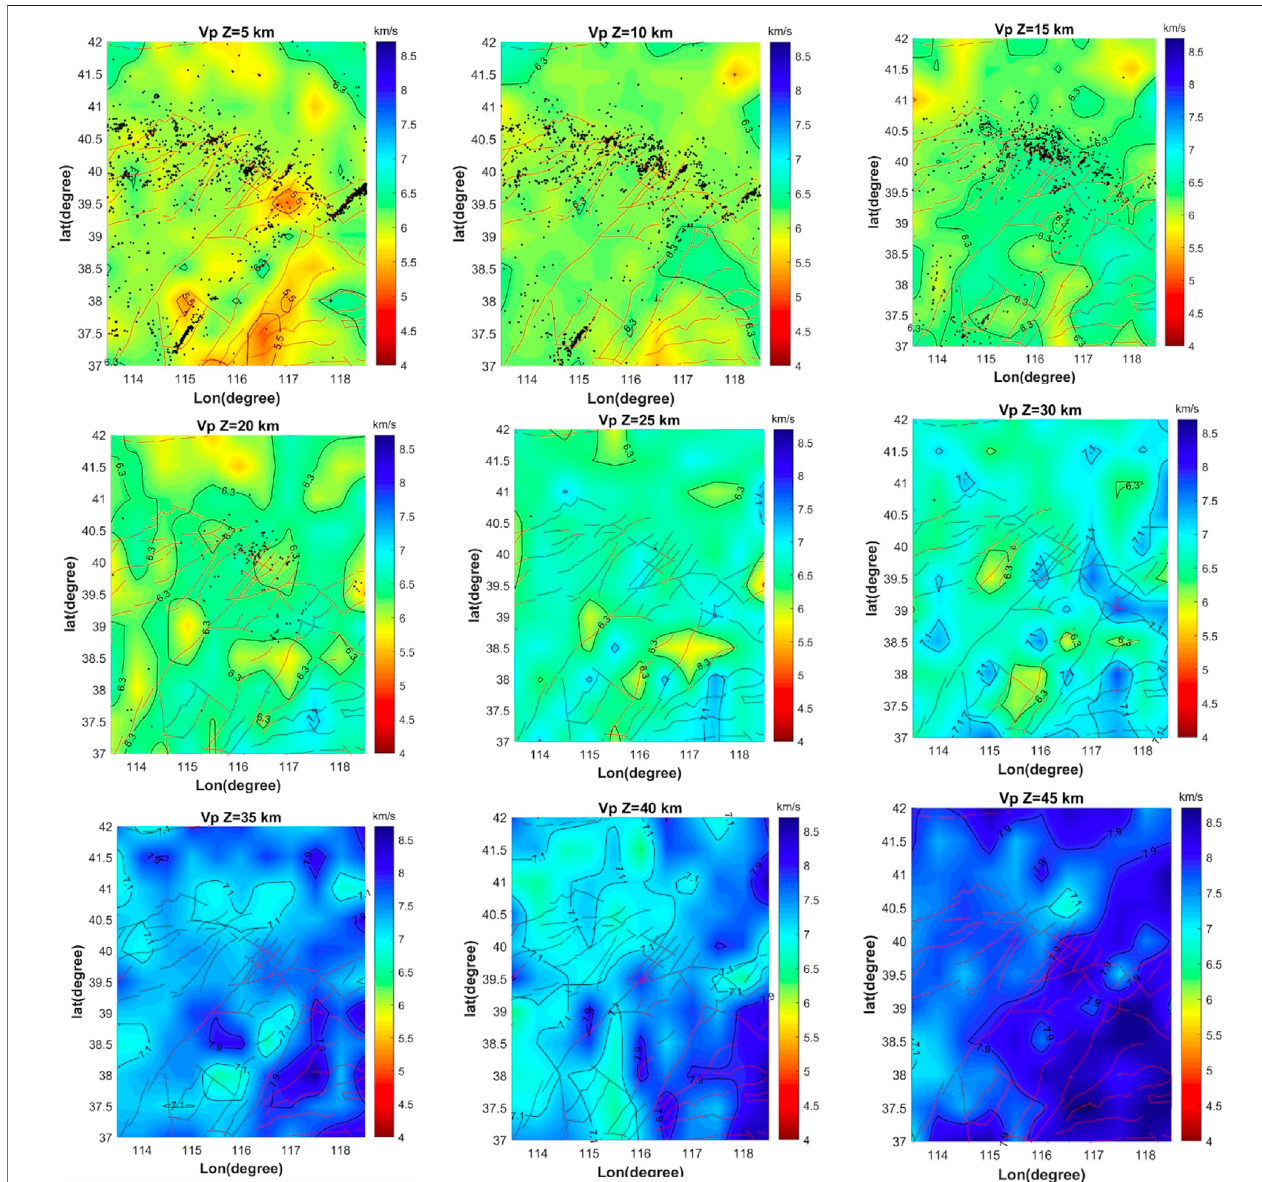
FIGURE 6 | P-wave velocity image at each depth slice. The depth of each layer is shown on the top of each map. Red and blue colors denote low and high velocities, respectively. Black dots indicate the relocated seismicity within ±2.5 km distance of the pro fi le lines. The red curved line shows major active faults.